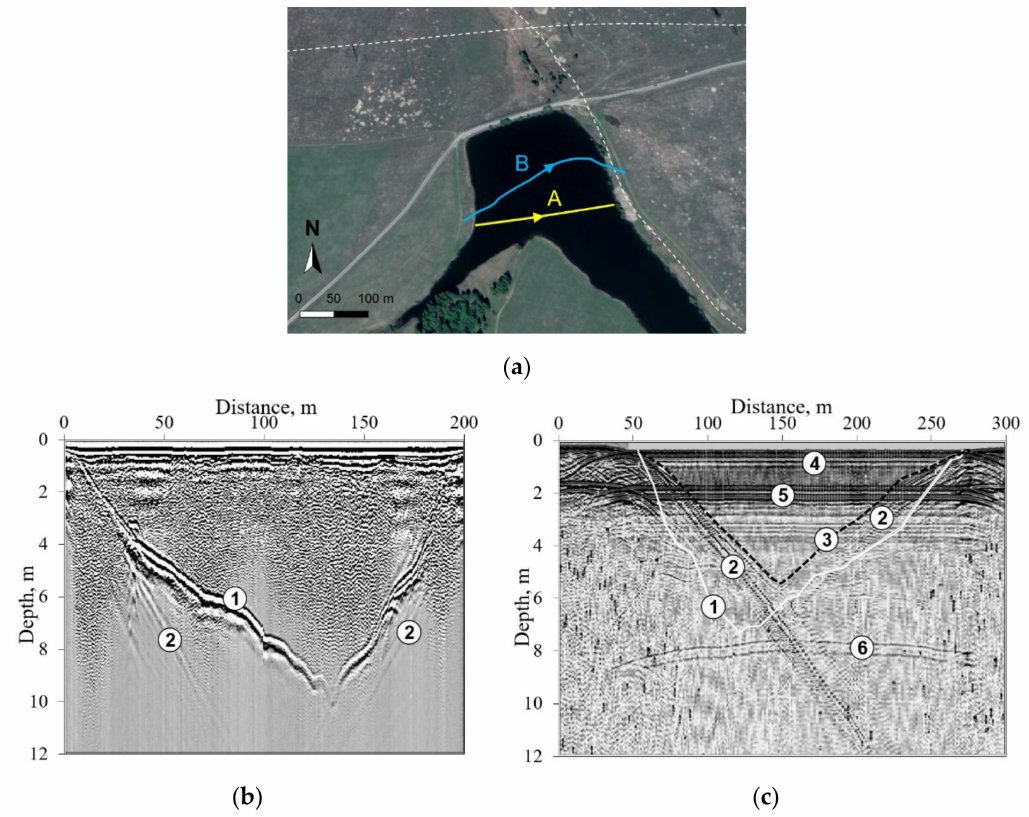
Figure 7. GPR probing of the lake bottom: ( a )—satellite image of the area, GPR survey from ice corresponds to yellow route (A), GPR survey from helicopter—blue route (B), white dashed lines denote air power lines; ( b )—B-scan from ice; ( c )—B-scan from helicopter. Notations: ( 1 ) lake bottom line, according to sounding data from ice, transferred as white solid line in ( c ); ( 2 ) reflected wave from the lake shore; ( 3 ) lake bottom, according to sounding data from helicopter, highlighted by black dashed line; ( 4 ) reflection from the lake surface; ( 5 ) interference, secondary reflection from the helicopter; ( 6 ) interference from power